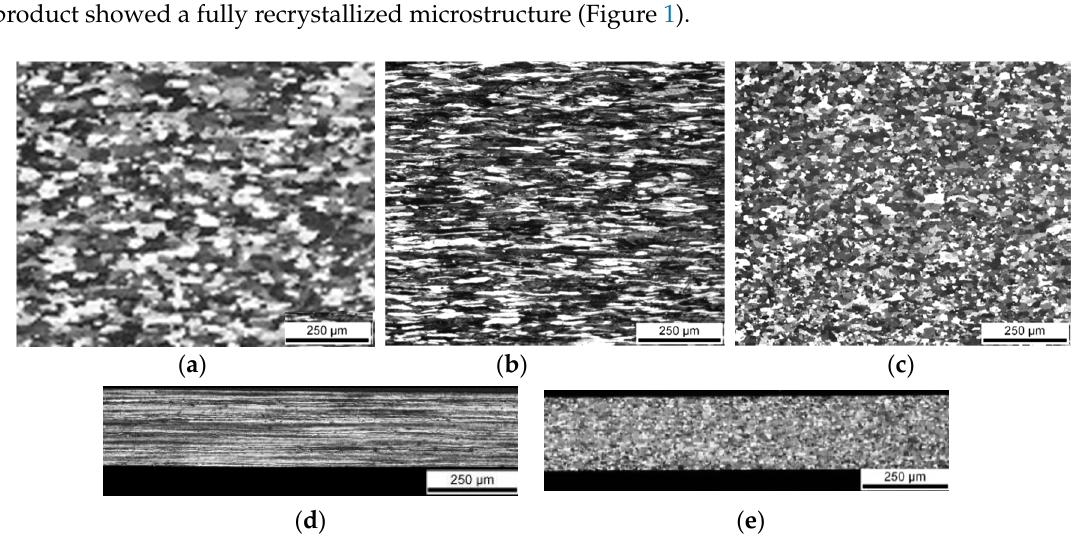
Figure 1. The microstructure of ( a ) hot-rolled sheet, ( b ) cold-rolled 1.3 mm sheet, ( c ) cold-rolled 1.3 mm annealed sheet, ( d ) cold-rolled 0.214 mm sheet and ( e ) cold-rolled 0.214 mm annealed sheet after Barker’s etching.